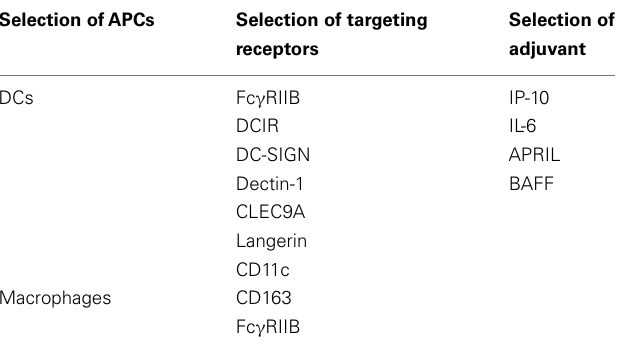
Table 1 | Strategy to design aAPC-targeted vaccine